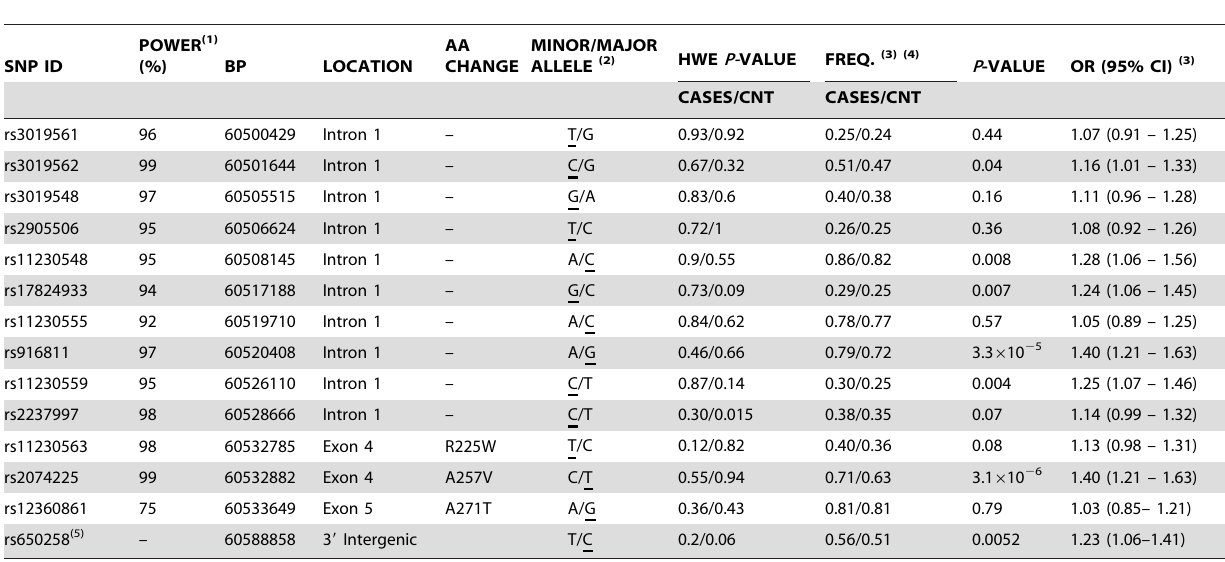
Table 2. Association analysis of 14 CD6 SNPs in the northern Spanish-Basque